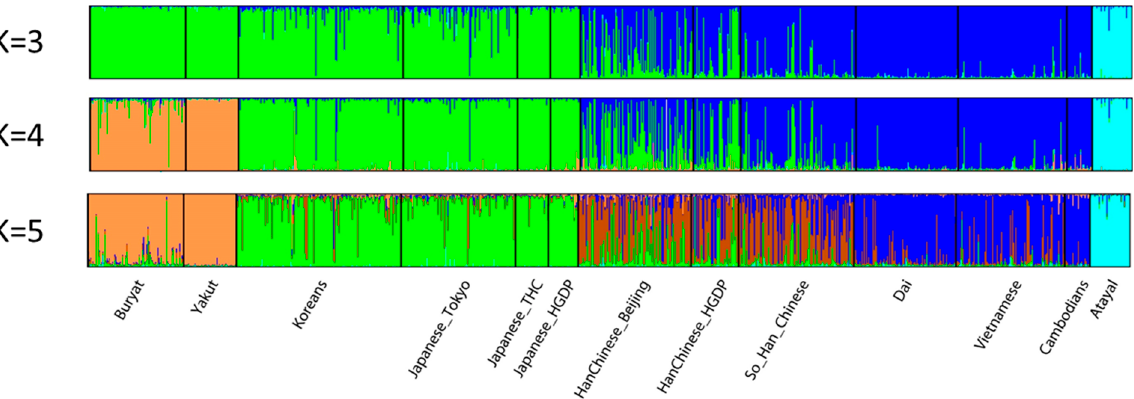
Figure 6. Individual bar plots of 13 East Asian population samples from STRUCTURE runs of the 90 MH dataset. This reanalysis with STRUCTURE was conducted by omitting other populations studied in [14]. The results of the highest likelihood runs at K = 3, 4, and 5 are shown.